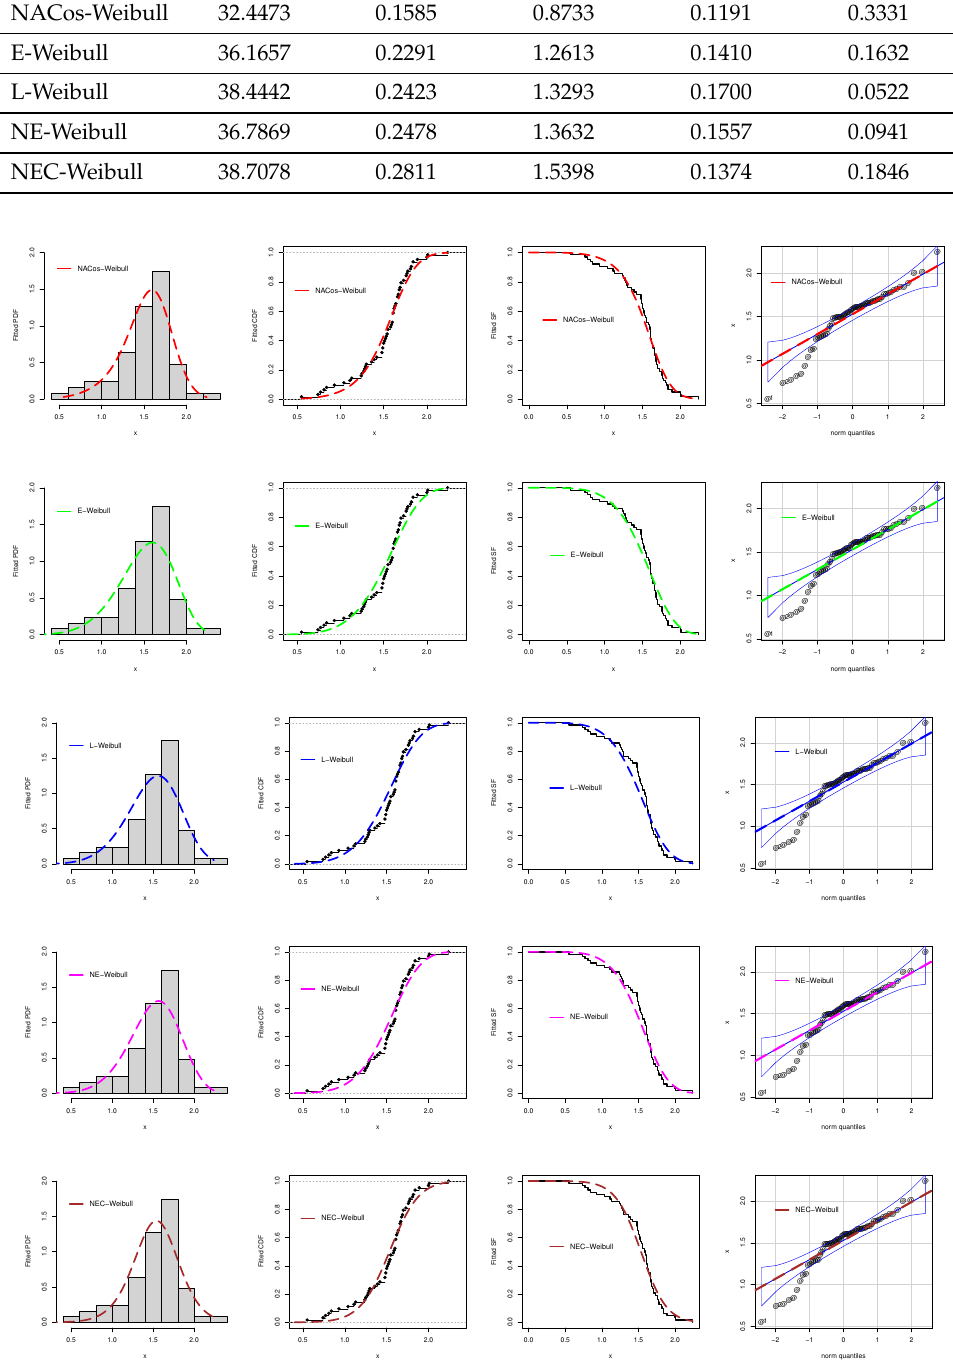
Figure 14. The visual comparison of the fitted models using the glass fibers data